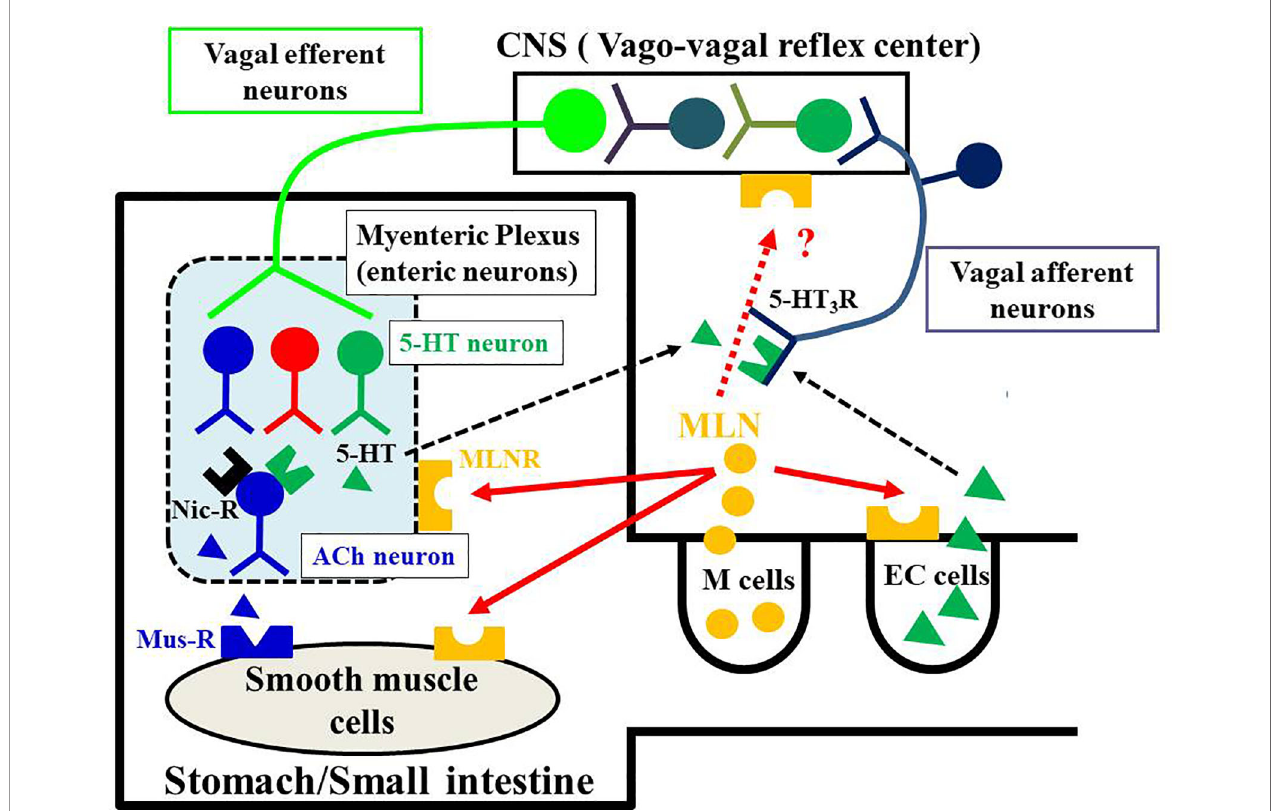
FIGURE 3 | Potential mechanisms of motilin-induced GI motor-stimulating actions. Motilin is synthesized in the M cells of the upper GI tract and is released by various stimuli, including mechanical, chemical, and biological. The released motilin causes GI motility-stimulating actions through motilin receptors (MLN-Rs) located on enteric neurons and smooth muscle cells. Neural pathways in the enteric nervous system are complex. Motilin stimulates neural pathways including cholinergic nicotinic receptors (black), adrenergic receptors, serotonin (5-HT) receptors and NO neurons, and fi nally acetylcholine (ACh, blue triangle) released from cholinergic neurons (blue) acts on muscarinic receptors (Mus-R) on smooth muscle cells to cause contraction of stomach and upper intestine. Results of experiments in conscious animals (dogs, humans and Suncus ) indicate that motilin stimulates the release of 5-HT from enteric serotonergic neurons (green) and 5-HT (green triangle) activates both enteric cholinergic neurons and the vago-vagal re fl ex pathway through activation of the 5-HT 3 receptors on enteric neurons and afferent vagal terminals. The stimulation of vagus efferent neurons activates neurons in the myenteric plexus to cause contraction of stomach. Since MLN-R is also present in the intestinal mucosa, it is possible that motilin acts on enterochromaf fi n cells (EC cells) to release 5-HT. The 5-HT originating from EC cells could also act on enteric neurons and the vagus afferent terminals. The contribution of these mechanisms might be different depending on the species, regions, and experimental conditions. The vago-vagal re fl ex pathway has been demonstrated mainly in the stomach but not in the small intestine. The MLN-R is also expressed in the CNS, but its functional roles in stimulating GI motility is